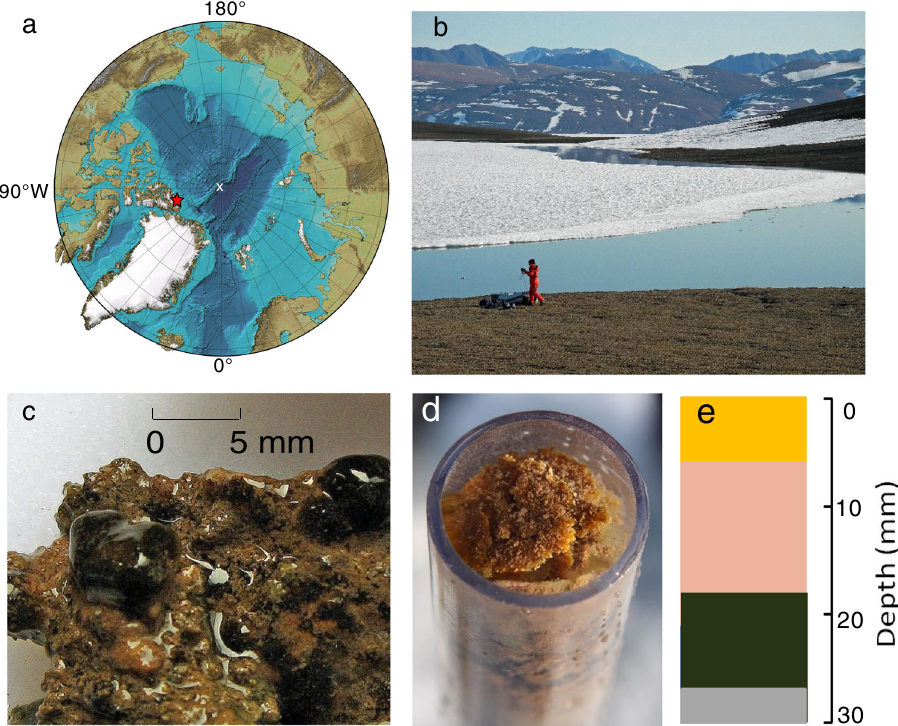
Fig. 1 The high Arctic sampling site and bio fi lms. a Location of Ward Hunt Lake ( red star ) relative to the North Pole ( white cross ); the base map is the International Bathymetric Chart of the Arctic Ocean (IBCAO) of the Intergovernmental Oceanographic Commission (IOC), version 3.0 released in the public domain on 8 June 2012; 20 b Ward Hunt Lake in mid-July 2015 showing the littoral open water zone (moat) and multi- year ice over the deeper waters of the lake; c Shallow bio fi lm over the rocks in the moat zone; d Sample of the deep bio fi lm in a mini-Glew sediment core (38 mm diameter) from 10 m depth; and e Schematic diagram of the bio fi lm color zonation (description in Supplementary the rDNA OTUs (Supplementary Table S2). Results from the phylogenetic clustering (Fig. 2 and Supplementary Fig. S1) and net relatedness indices (Supplementary Fig. S2) were consistent with habitat fi ltering 12 (environmental selection of speci fi c genotypes).